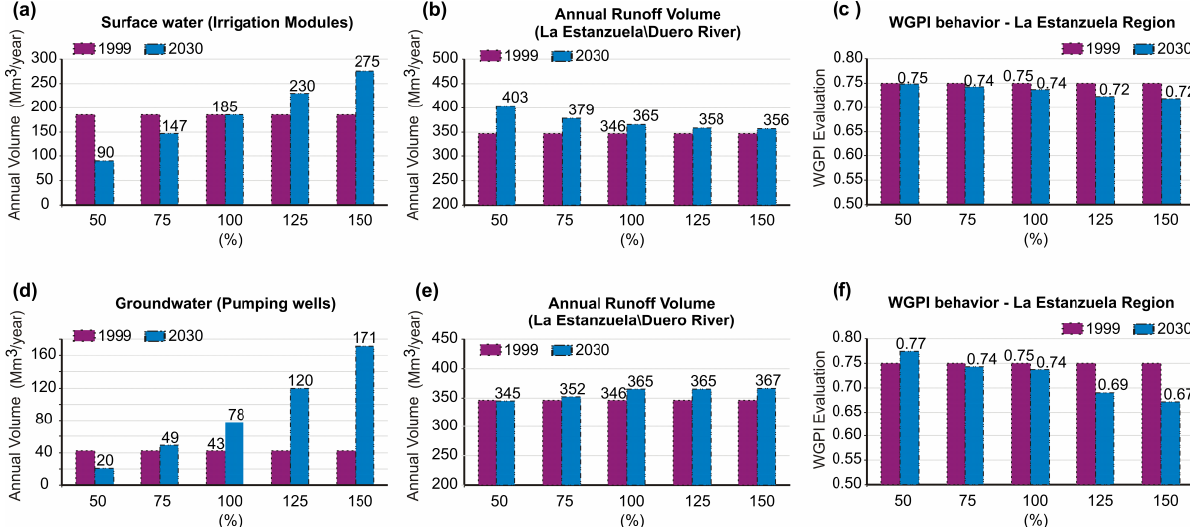
Figure 11. Percentage variation and comparison between the surface water volumes used for agricul- ture ( a ) and groundwater pumping to supply various uses ( d ), as well as its implication in the